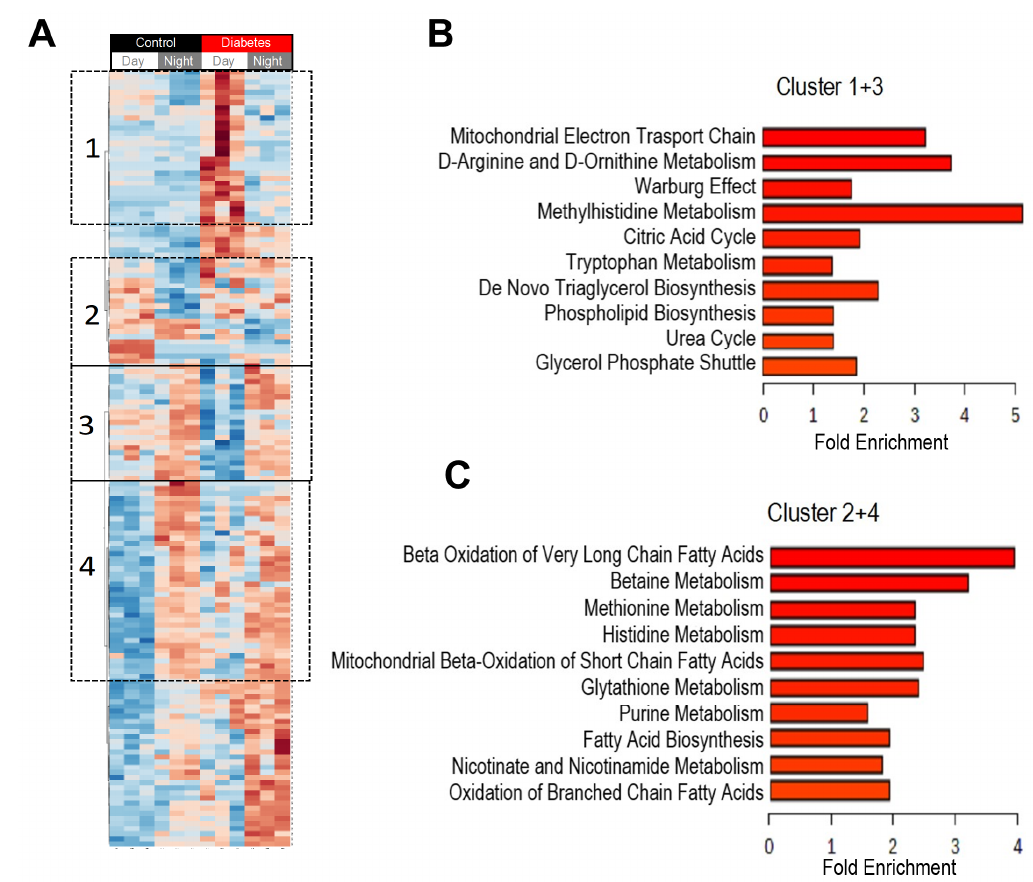
Figure 3. Heatmap of plasma metabolites that changed during the transition from day to night. Blood samples were collected at day time (ZT5) and at night time (ZT17) from 10-month-old db / db (diabetic) and aged-matched db / m (control) mice. Untargeted global metabolomics analysis was performed with the Metabolon Platform (Metabolon Inc). MetaboAnalyst was used for the analysis. ( A ) Heatmap of statistically significant metabolites. We identified clusters that gained diurnal rhythmic patterns (increased (Cluster 1) or decreased (Cluster 3) in diabetes in the day but did not change in controls and clusters that lost diurnal rhythmic patterns in diabetes (increased (Cluster 2) or decreased (Cluster 4) in control in the day but did not change in diabetes. ( B ) Enrichment analysis of metabolites that gained rhythmic patterns in diabetes (Cluster 1 and 3). ( C ) Enrichment analysis of metabolites that lost rhythmic patterns in diabetes (Cluster 2 and 4). n = 3 per time point per